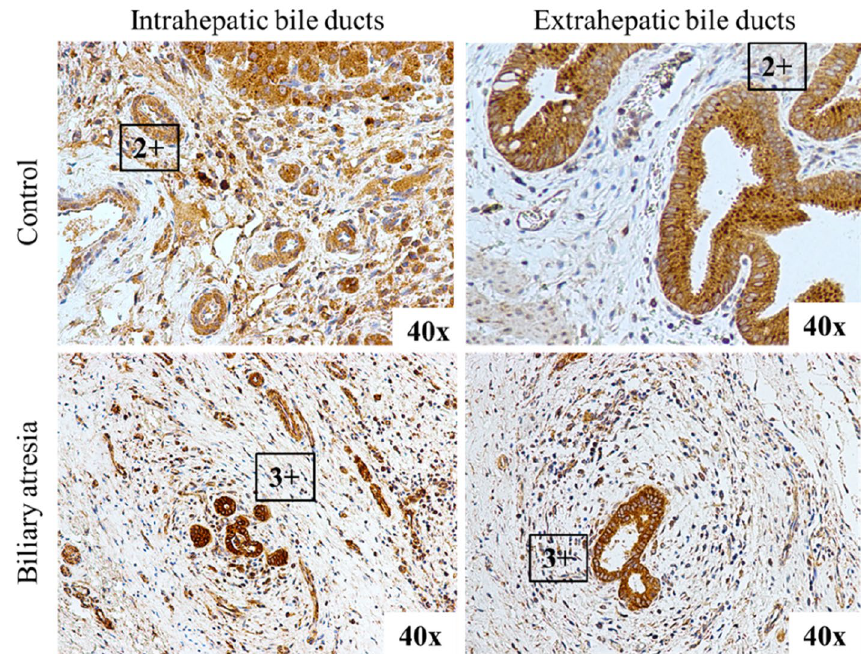
Figure 2. Fibulin-3 immunostaining in biliary epithelium showing the overexpression and loss of apical granules within the intrahepatic bile ducts in biliary atresia patients.